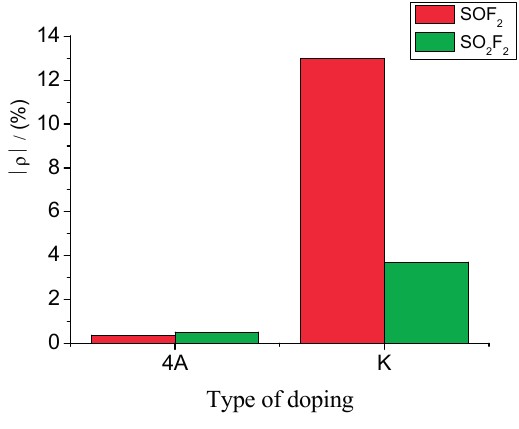
Figure 12. Gas-sensing selectivity of MWNT sensors to SOF 2 and SO 2 F 2 .